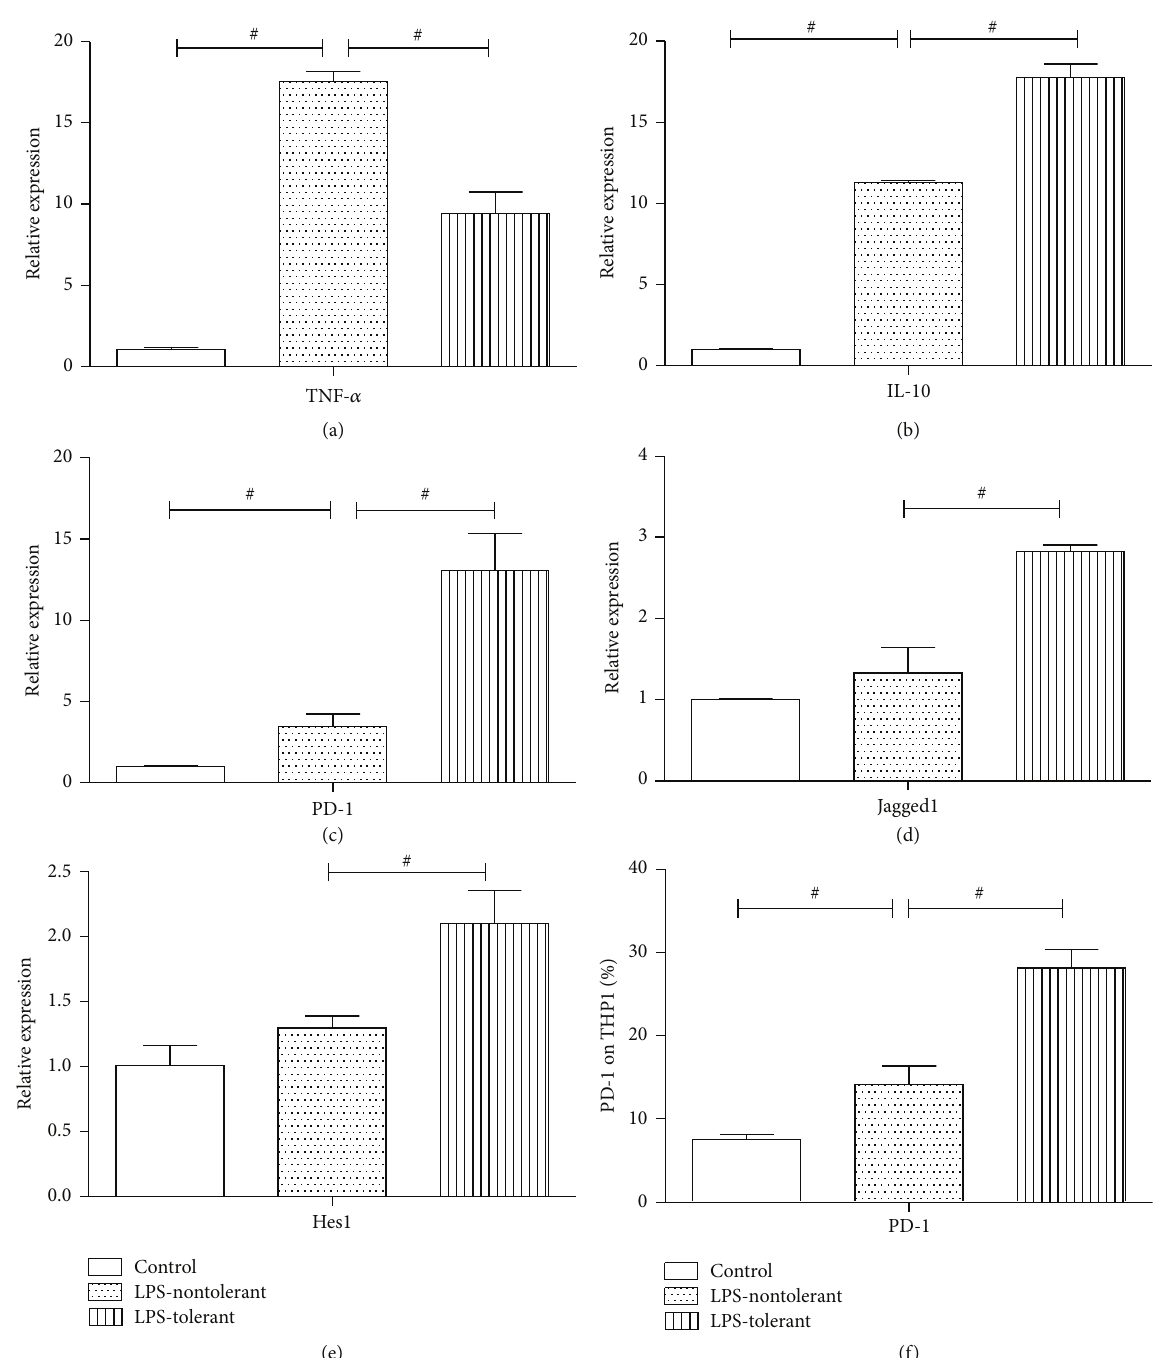
Figure 2: PD-1 and Notch-related molecules levels in LPS-tolerant THP1 cells. THP1 cells were pretreated with 1.0 𝜇 g/mL LPS for 16h. Then, nontreated and pretreated THP-1 cells were pelleted, washed once in PBS, and resuspended in culture media at 5.0–10.0 × 10 5 cells/mL. Finally, cells of both groups were stimulated with LPS (1.0 𝜇 g/mL) for another 6 hours to make LPS-nontolerant and LPS-tolerant models. The control group was not given any stimulation. After above treatment, cells were washed for three times and total RNA was extracted. The mRNA levels of TNF- 𝛼 (a), IL10 (b), PD-1 (c), Jagged1 (d), and Hes1 (e) and protein levels of PD-1 (f) were examined in control, LPS-tolerant, and LPS-nontolerant groups. Data shown are normalized to 𝛽 -actin mRNA and presented as 2 −ΔΔ CT . # 𝑃 value <